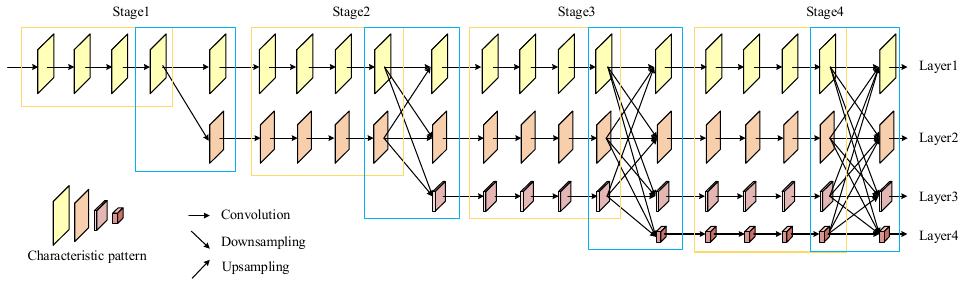
Figure 7. HRNet network structure.